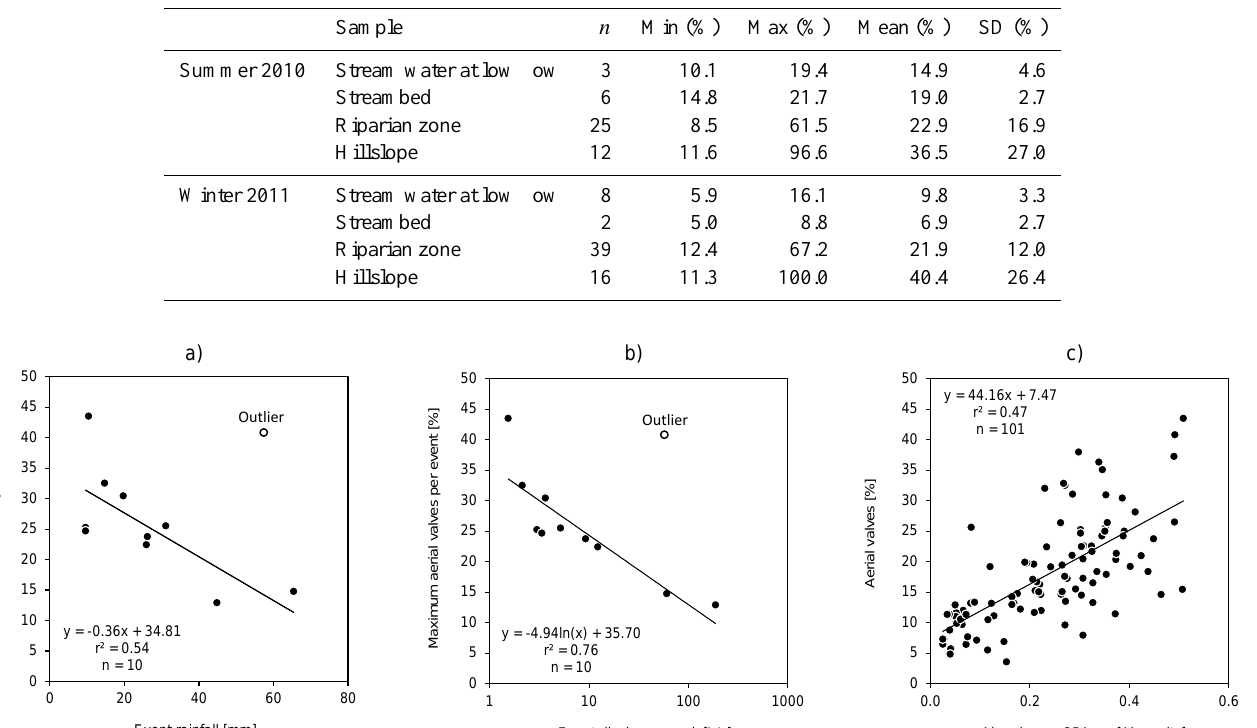
Figure 10. Correlations between (a) maximum percentage of aerial valves in the stream water per event and event rainfall, (b) maximum percentage of aerial valves in the stream water per event and maximum event discharge, and (c) percentage of aerial valves in the stream water and UV absorbance at